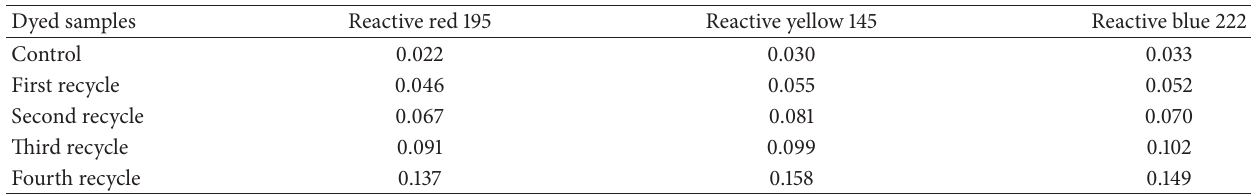
Table 4: Relative unlevelness index (RUI) values of dyed